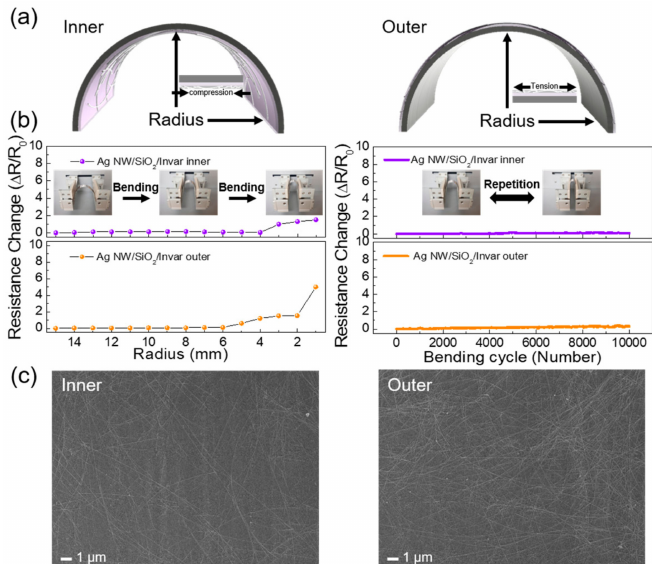
Figure 5. Mechanical properties of brush-painted Ag NW network electrode on SiO 2 / invar metal substrate measured by lab-designed equipment. ( a ) Schematic image of inner and outer bent sample indicating the bending radius. ( b ) Resistance change of brush painted Ag NW electrode with decreasing the inner and outer bending radius (left) and dynamic fatigue test (right) in which the resistance change was measured in-situ. The dynamic fatigue test measured resistance change during repeated inner and outer bending at a fixed radius of 15 mm. Insets show steps of bending test and dynamic fatigue test. ( c ) Surface FE-SEM image of brush-painted Ag NWs network electrode after inner and outer dynamic bending fatigue tests.